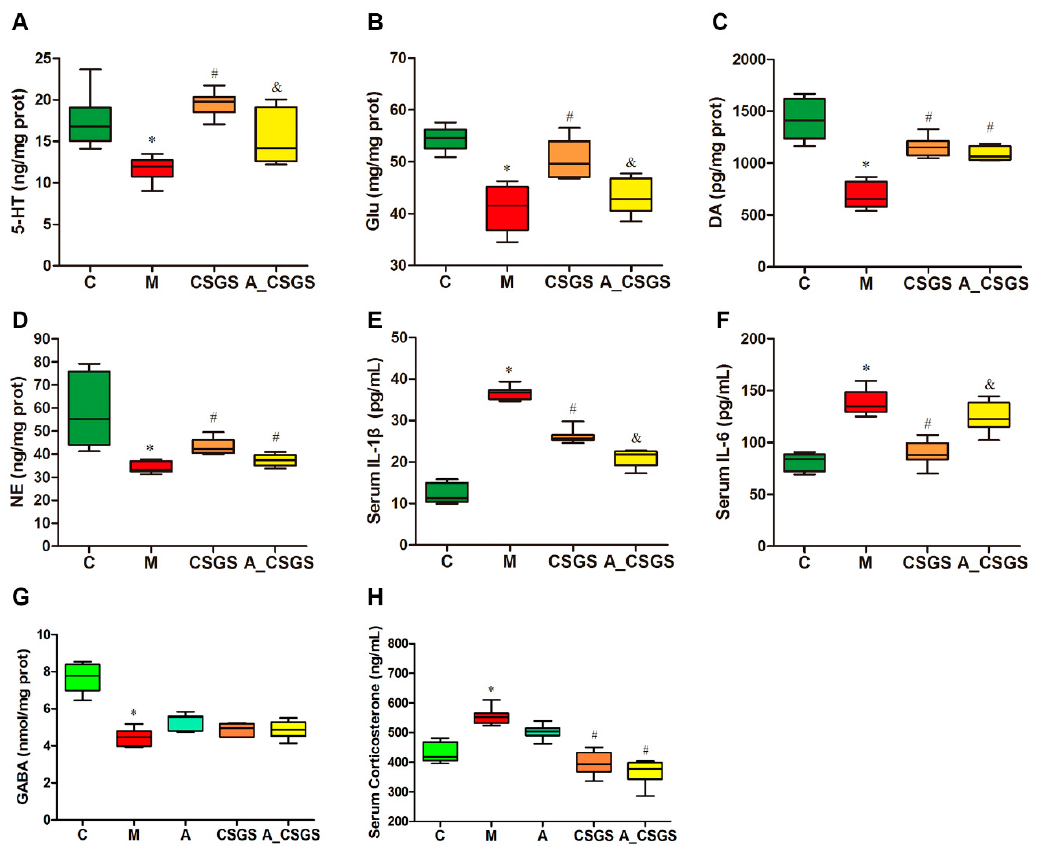
Figure 2. Hippocampal 5-HT ( A ), glutamic acid (Glu) ( B ), dopamine (DA) ( C ), noradrenaline (NE) ( D ), gamma-aminobutyric acid (GABA) ( G ), and serum corticosterone ( H ), and inflammatory factors IL-1 β ( E ) and IL-6 ( F ) levels in different treatment groups of rats. C: control group; M: CVS model group; A: Antibiotic treated group with CVS; CSGS: CSGS treated group; A_CSGS: Antibiotic + CSGS treated group. * p < 0.05 vs. C; # p < 0.05 vs. M; & p < 0.05 vs. CSGS. The post hoc ANOVA used for statistical analysis and data with different superscript letters are significantly different.